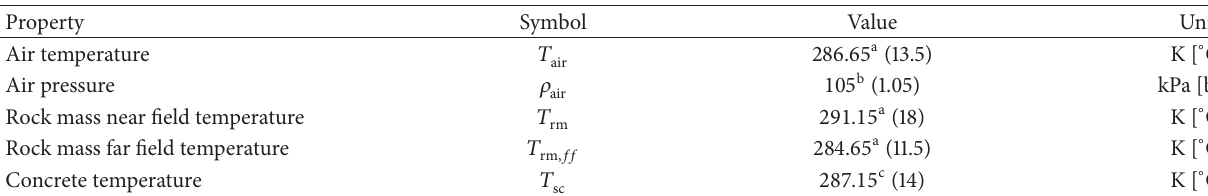
Table 7: Initial